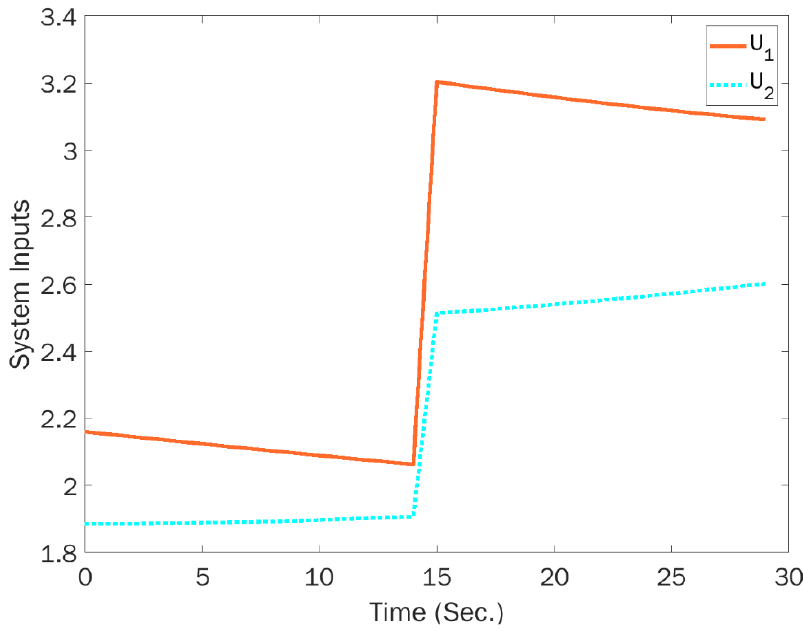
Figure 6. Shows inputs signals of the CSTH system.